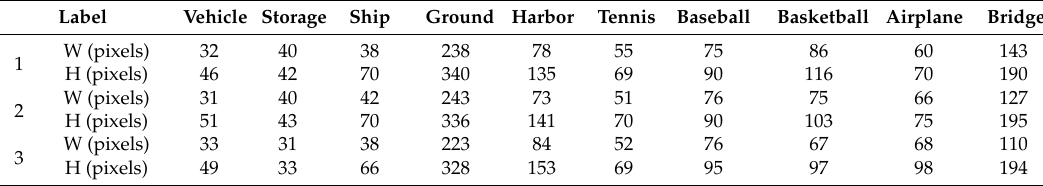
Table 4. Size of Class-specific Anchor for each category.